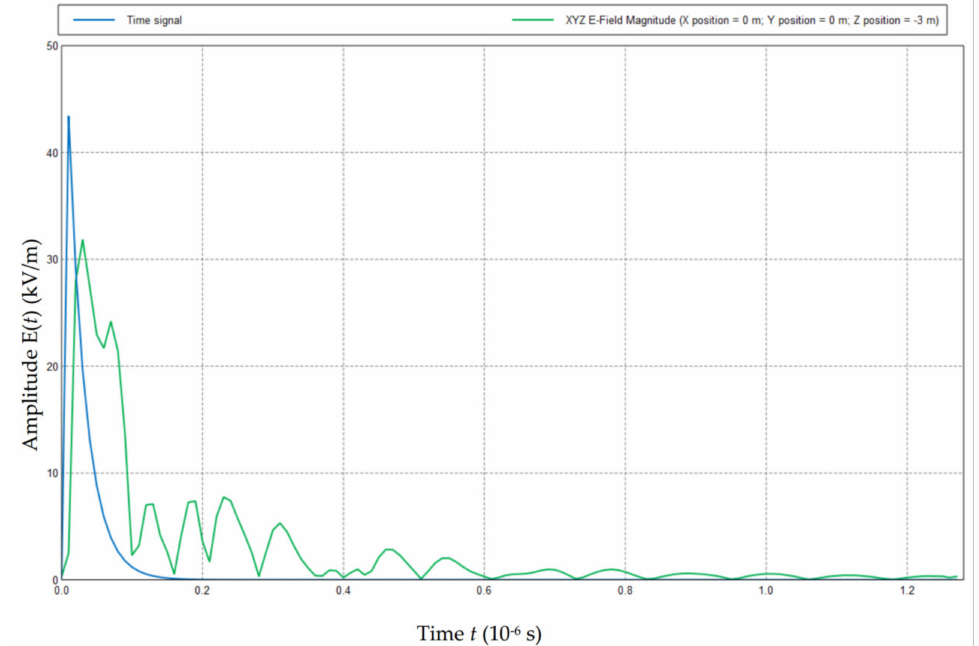
Figure 13. Tendencies of the electric field strength E ( t ) of various positions of bottom layer outside the